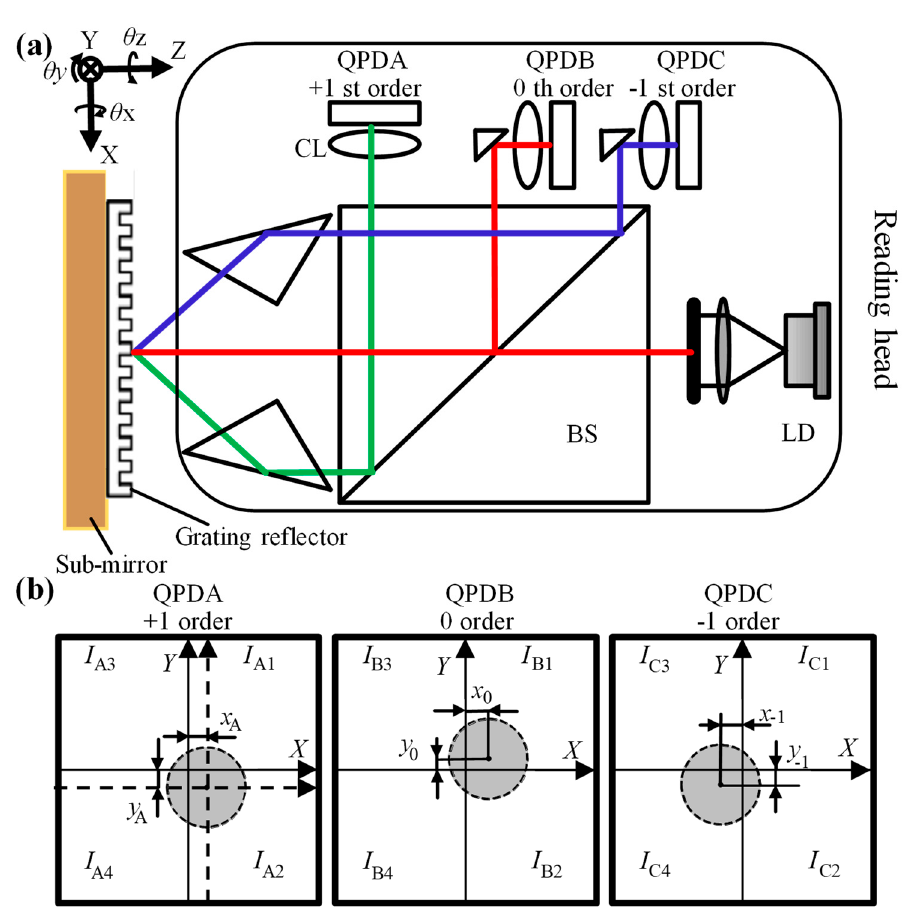
Figure 2. ( a ) The schematic of the encoder; ( b ) the spot coordinate of the QPDs. Taking QPDA as an example, due to different light intensity distributions, the coor- In these coordinates, the position of the 0th-order light change is only related to θ dinate value can be calculated from Formula (1). The coordinate origin of the two-dimen- sional coordinate system is the symmetric center of the four photodetectors. Due to the mechanical structure, it is difficult to adjust the light spot to be perfectly located at the symmetrical center of the QPD. Therefore, at the beginning of the test, the light spot is located at the position ( x A , y A ) of the coordinate system of the QPD, and x A and y A are very close to 0. The point ( x A , y A ) is used as the origin of a new QPDA coordinate system in Figure 2b, which is represented in the form of the dashed line. In the new QPD coordinate system, the light spot is located at the coordinate origin, The new coordinate systems of QPDB and QPDC are simultaneously established according to this method.